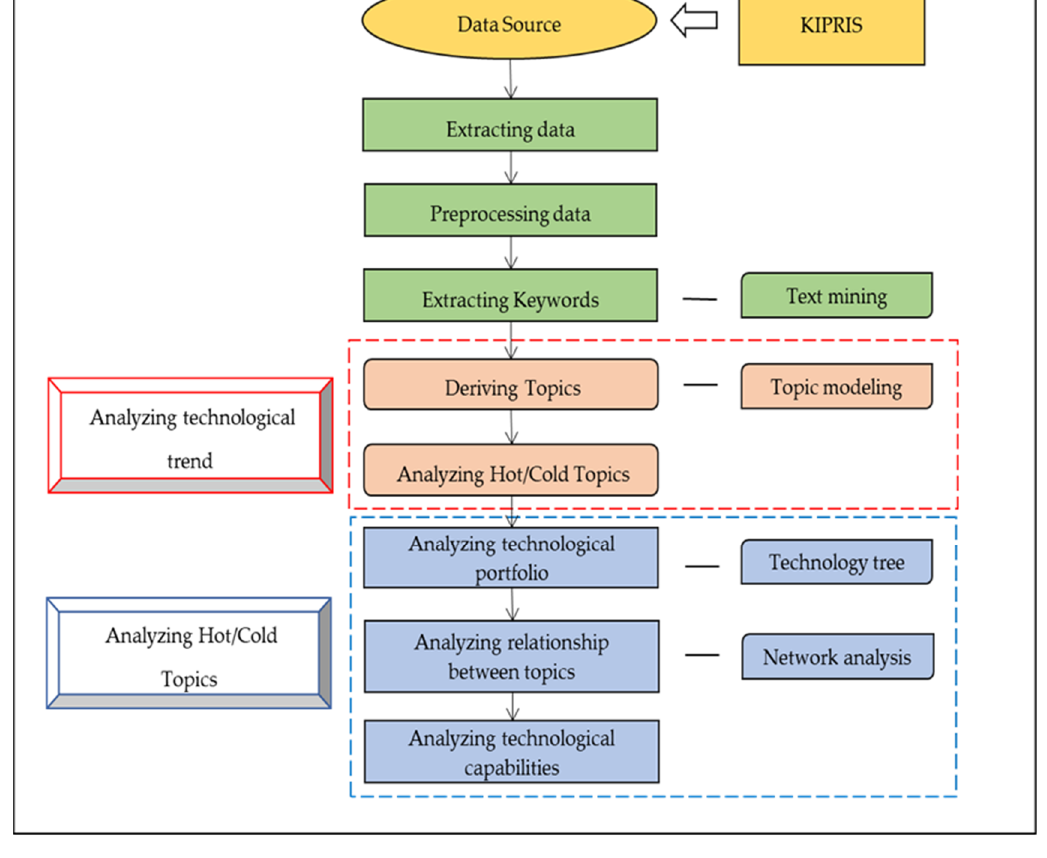
Figure 1. Research framework.